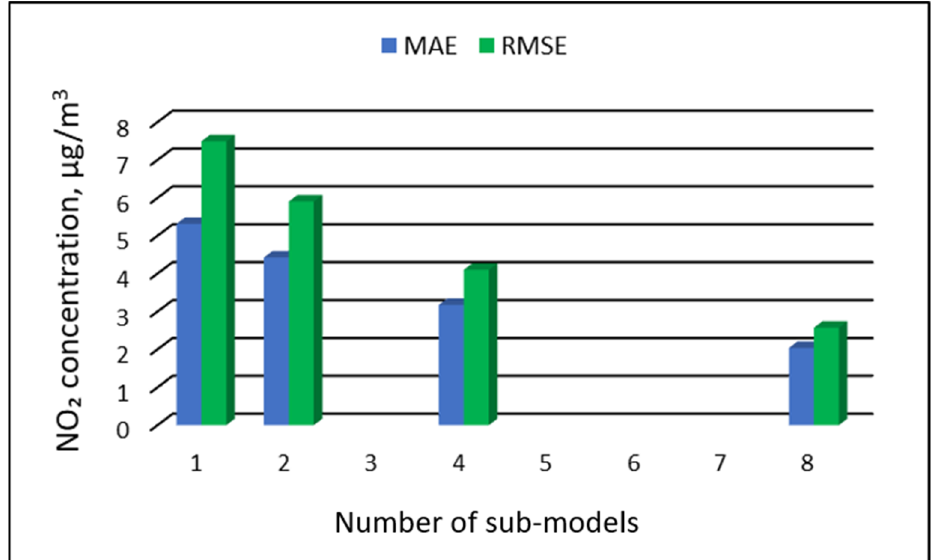
Table 14. Values of approximation errors of NO 2 concentrations in RVS models, Z ł oty Potok 2011– 2016.